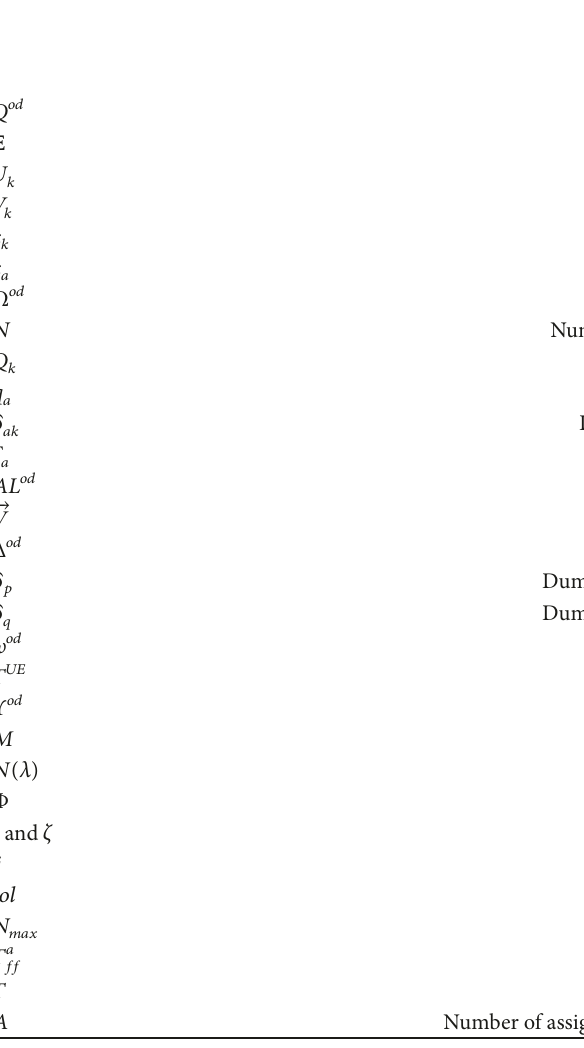
Table 1: Notations used in this paper.